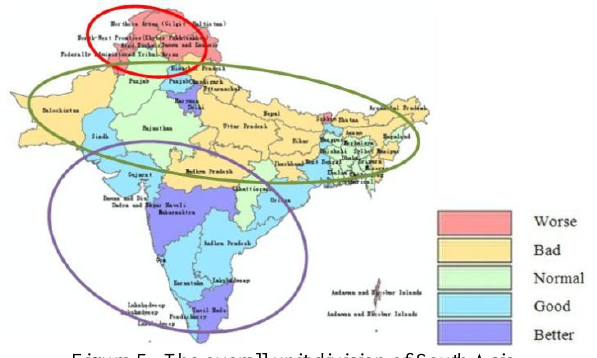
Figure 5. The overall unit division of South Asia From figure 5, we can see that south Asia can be roughly divided into three units on the comprehensive situation, the worse northern region, the general central region and the better southern